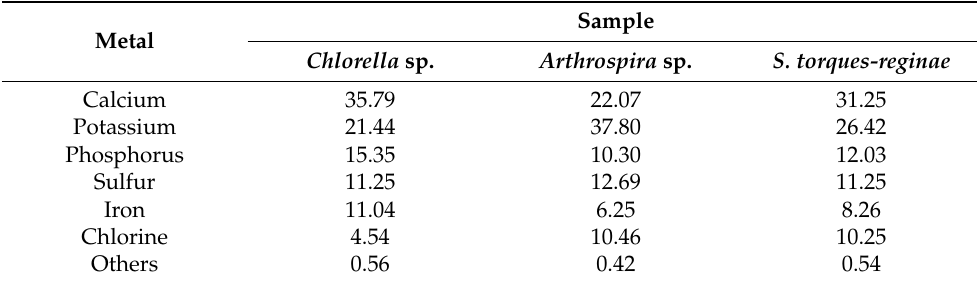
Table 2. Metal composition (%) of cyanobacterial and microalgal